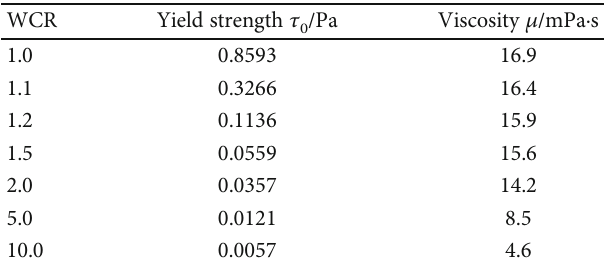
Table 1: The chemical composition of cement in the test. Ignition loss SiO 2